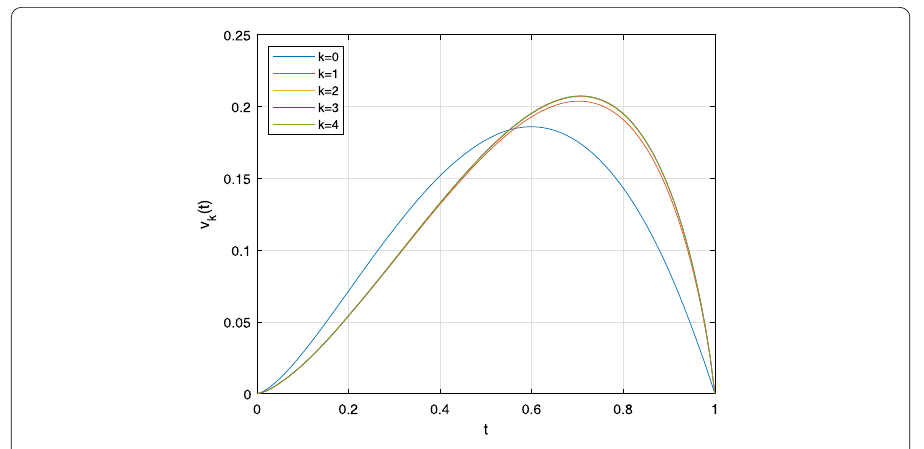
Figure 1 The approximation of the solution of problem (3.6)